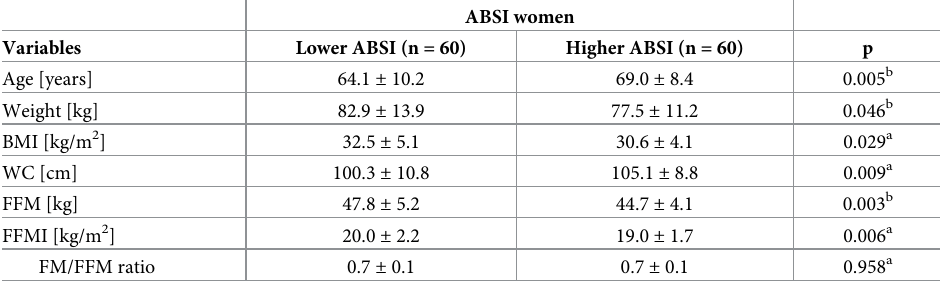
Table 6. Body parameters in female patients with lower and higher